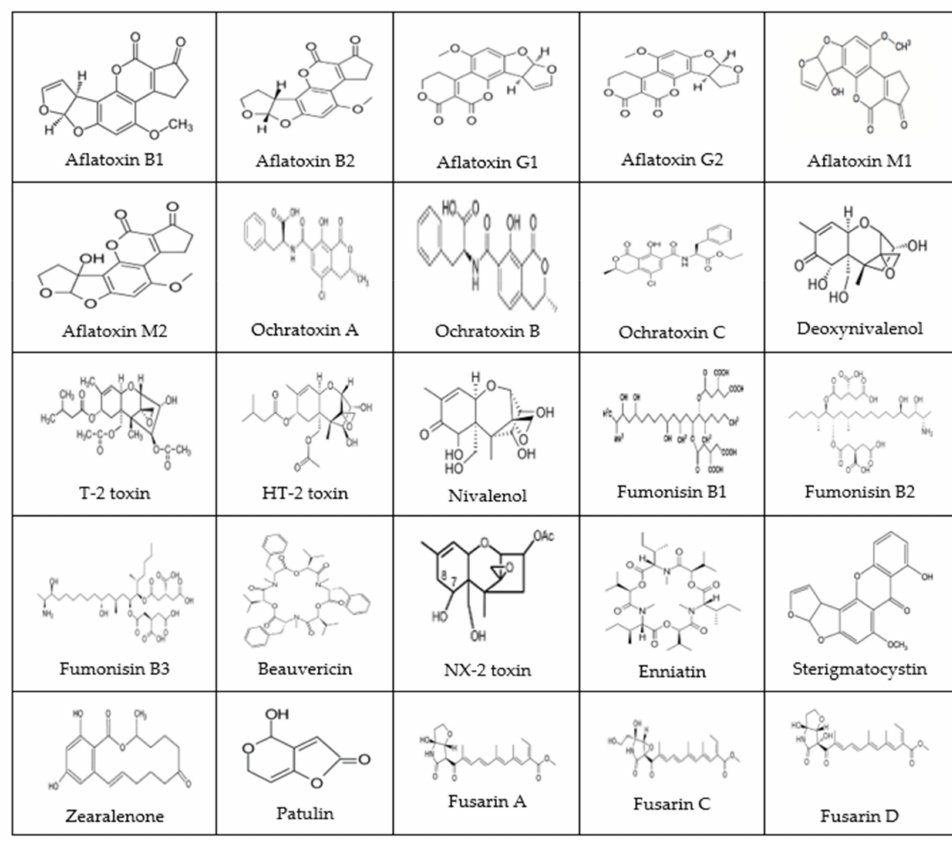
Figure 1. The chemical structures of common mycotoxins (Reprinted/Adapted from sources